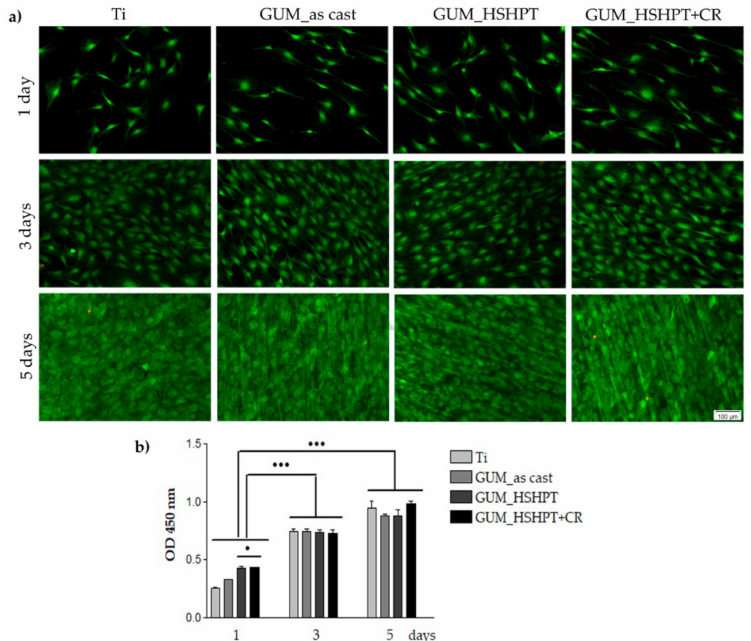
Figure 6. Viability and proliferation potential of MC3T3-E1 cells grown in contact with Ti, GUM in the as-cast state, GUM_HSHPT and GUM_HSHPT + CR surfaces for 1, 3 and 5 days. ( a ) Fluorescence microscopy images of the MC3T3-E1 cells stained with the LIVE / DEAD Cell Viability / Cytotoxicity Assay Kit (live cells: green fluorescence; dead cells: red fluorescence). Scale bar: 100 µ m; ( b ) results of the CCK-8 assay showing the proliferation ability of the cells grown on the analyzed surfaces ( n = 3, mean ± SD). • p < 0.05 for GUM_HSHPT and GUM_HSHPT + CR substrates vs. Ti at 1 day